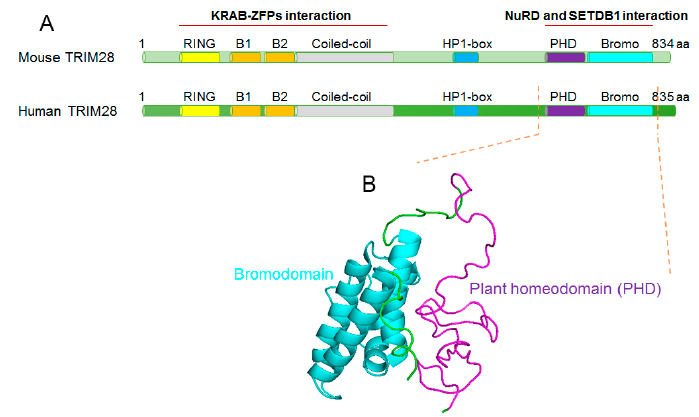
Figure 7. Structural characterization of tripartite motif-containing 28 (TRIM28) proteins. ( A ) Schematic diagrams are shown for mouse and human TRIM28 proteins. Conserved motifs include the RING finger, B boxes (B1 and B2), coiled-coil, HP1 binding box (HP1-box), plant homeo domain (PHD), and bromodomain (Bromo). The KRAB-ZFPs binding domain comprises the N terminal RBCC (RING finger, B boxes and coiled-coil) domain, while the NuRD and SETDB1 interaction domains are at the C terminus. ( B ) The nuclear magnetic resonance (NMR) solution structures of human TRIM28 PHD finger-bromodomain (residues 624–811; PDB ID: 2RO1). The plant homeodomain (PHD) and Bromodomain are coloured in magenta and cyan , respectively.